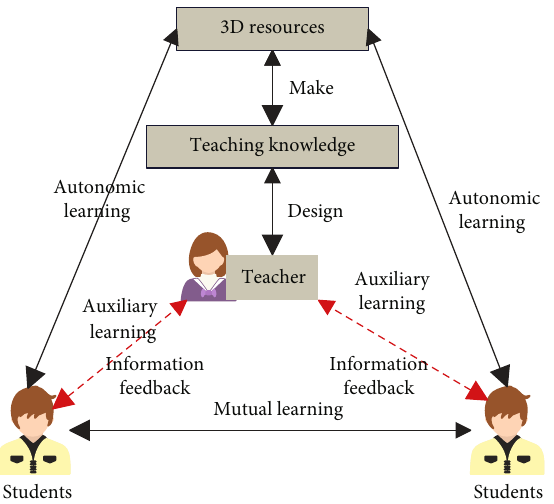
Figure 7: Immersive teaching relationship under